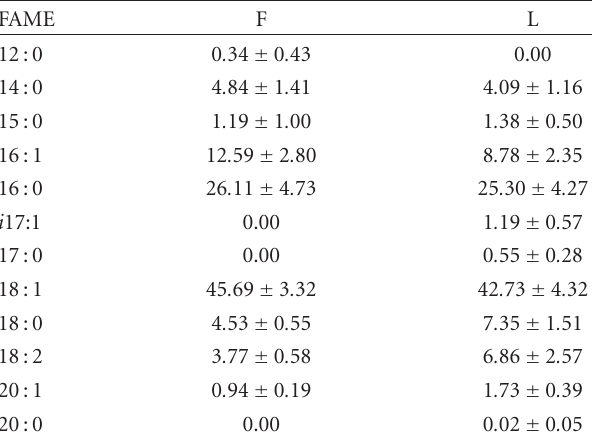
Table 2: The percentage of fatty acids present in deep-frozen (F) and lyophilized (L) human bone tissue.